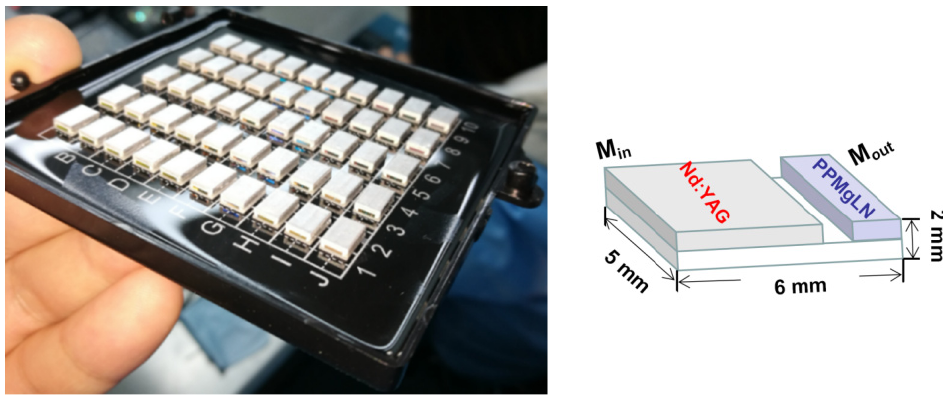
Figure 1. The physical picture (left) and the schematic drawing (right) of the Nd:YAG/PPMgLN module. The length of the PPMgLN crystal is 2 mm. The left facet of the PPMgLN crystal has an HT coating at 561.5, 946.0, 1064.0, 1123.0 and 1319.0 nm. The right facet (M out ) has an HR coating at 1123.0 nm and an HT coating at 561.5, 946.0, 1064.0 and 1319.0 nm.